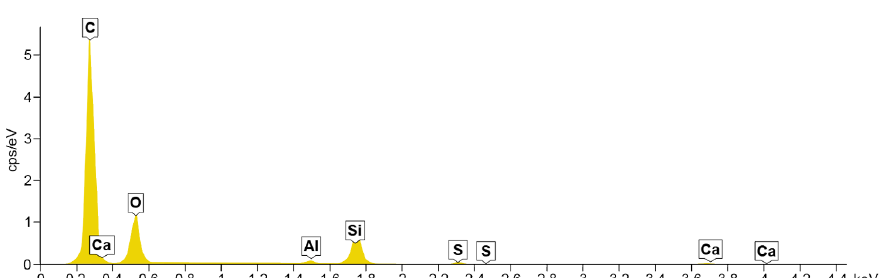
Figure 10. EDS for material